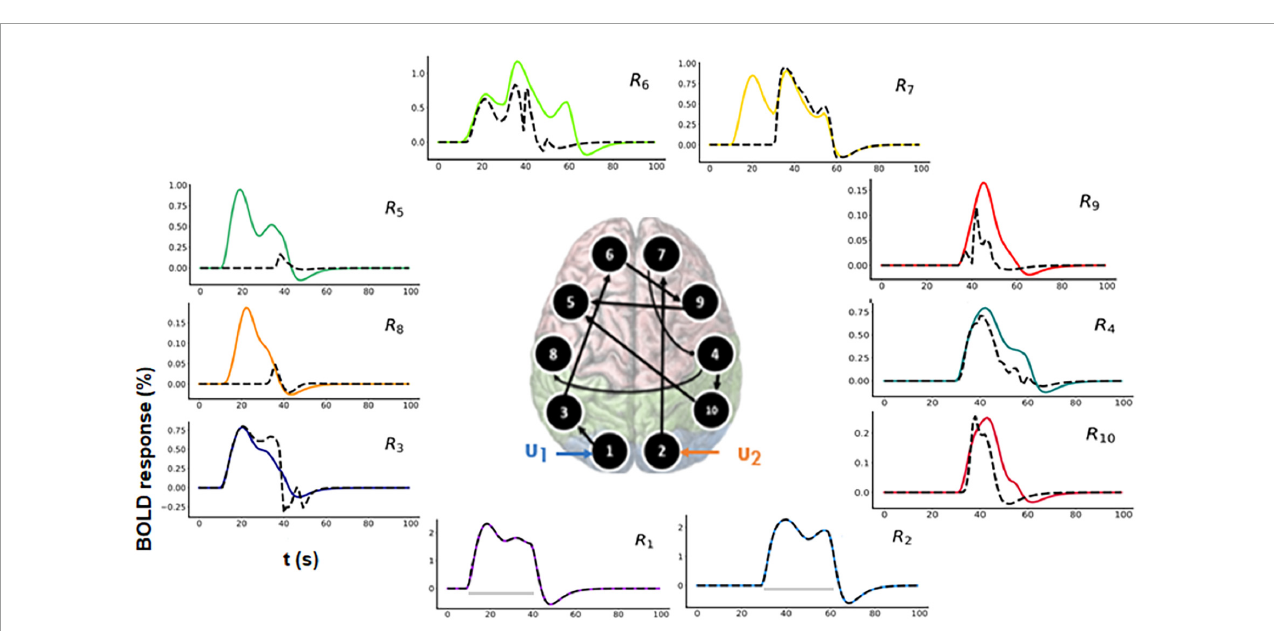
FIGURE7 Predicted area-specific functional magnetic resonance imaging (fMRI) blood oxygenation level-dependent (BOLD) time courses along with the ground truth values for m 2 which is a randomly chosen model. The black dashed lines represent the predicted responses and the colored time courses are the ground truth values. There are fitting inconsistencies for R3, R4, R5, R6, R7, R8, R9, and R10 fMRI BOLD time